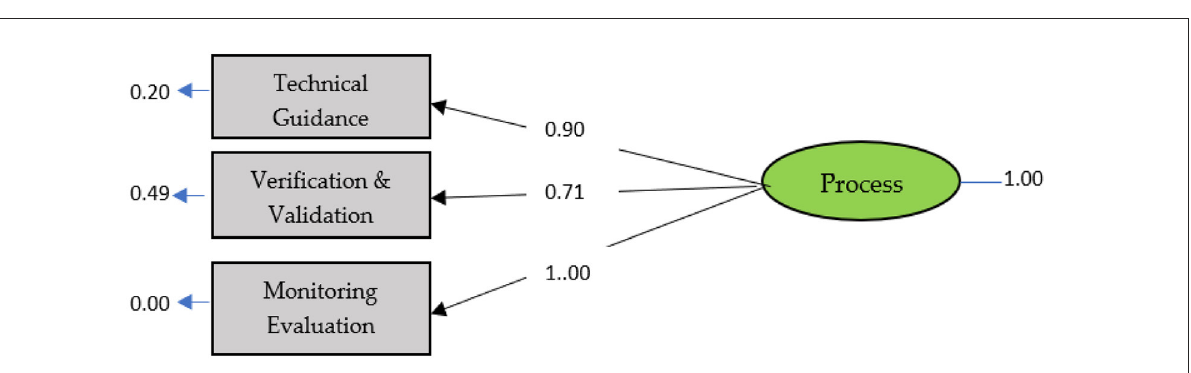
FIGURE3 Standard process model